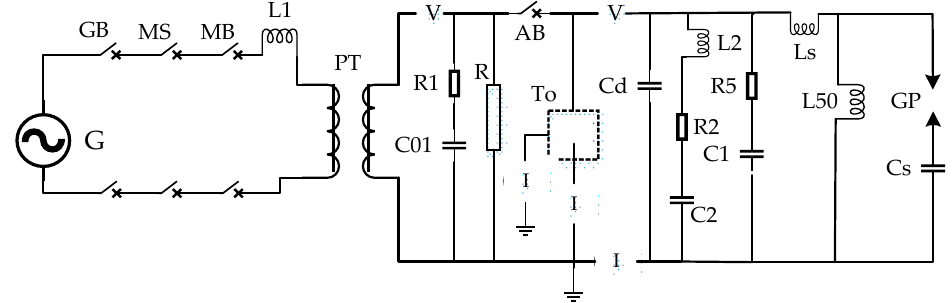
Figure 8. Breaking test circuit for the 363 kV VCB . G, generator; GB, generator breaker; MS, make switch; MB, master breaker; L, reactor; PT, power transformer; R, resistor; C, capacitor; To, test object; R, arc prolonging circuit; V, voltage measurement; GP, gap; I, current measurement; AB, auxiliary breaker.